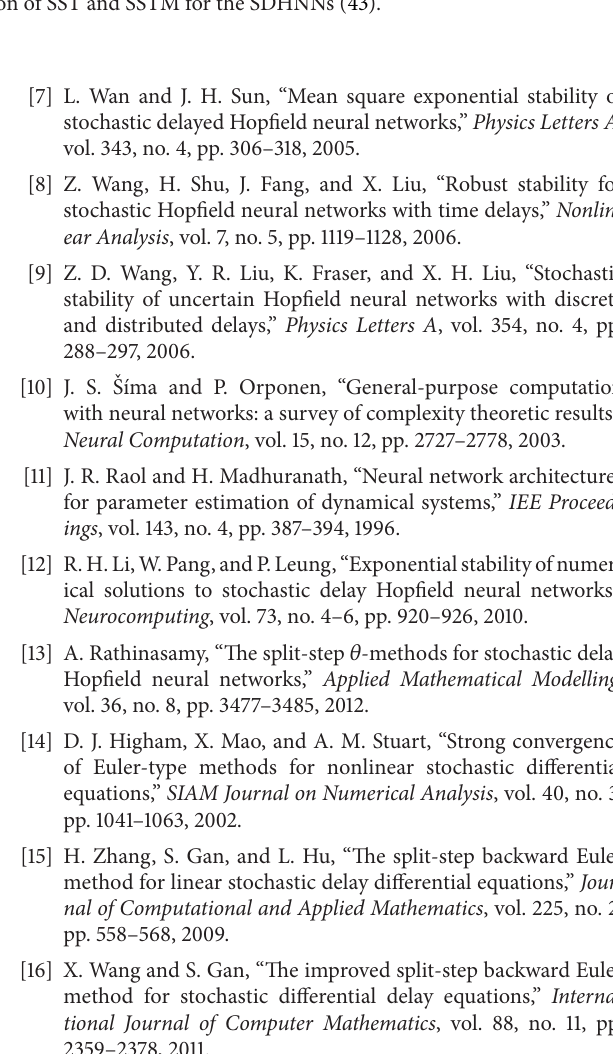
Figure 6: Mean-square stability comparison of SST and SSTM for the SDHNNs